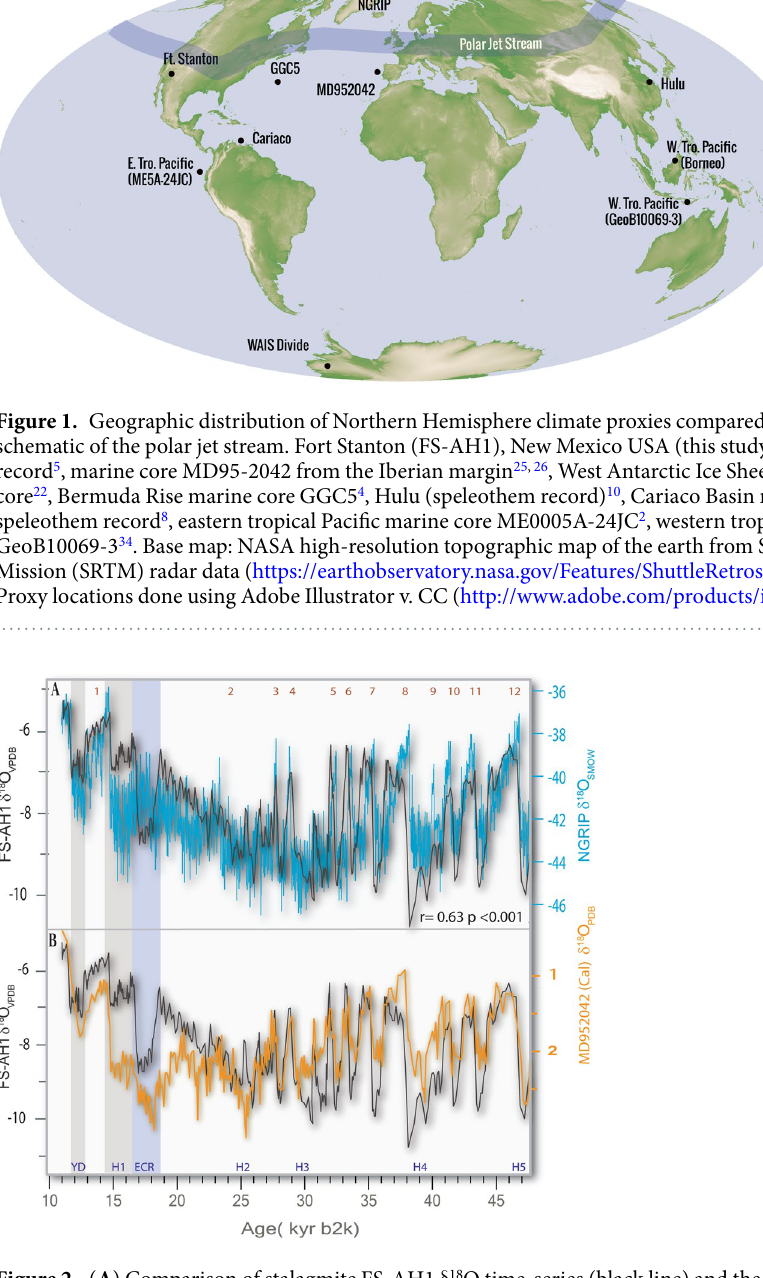
of Mexico and Gulf of California, with δ 18 O in the range of − 3‰, and Pacific-derived winter precipitation with low δ 18 O, in the range of − 11‰ 17 . In addition to changes in the balance between winter and summer moisture, a fraction of the large range in precipitation and speleothem δ 18 O is attributed to temperature variability 7, 17 , estimated to be 5–6 °C for the region 18 from the LGM to the Holocene. The balance between winter and summer precipitation contribution to cave infiltration is modulated by changes in the meridional position of the Northern Hemisphere Polar Jet 19 . Concurrent changes in the Asian monsoon but with the opposite effect on δ 18 O was explained as reflecting changes in position of the intertropical convergence zone (ITCZ) 7 . Alternatively, it was also suggested that ITCZ displacement during North Atlantic stadials, leading to strengthening of winter time